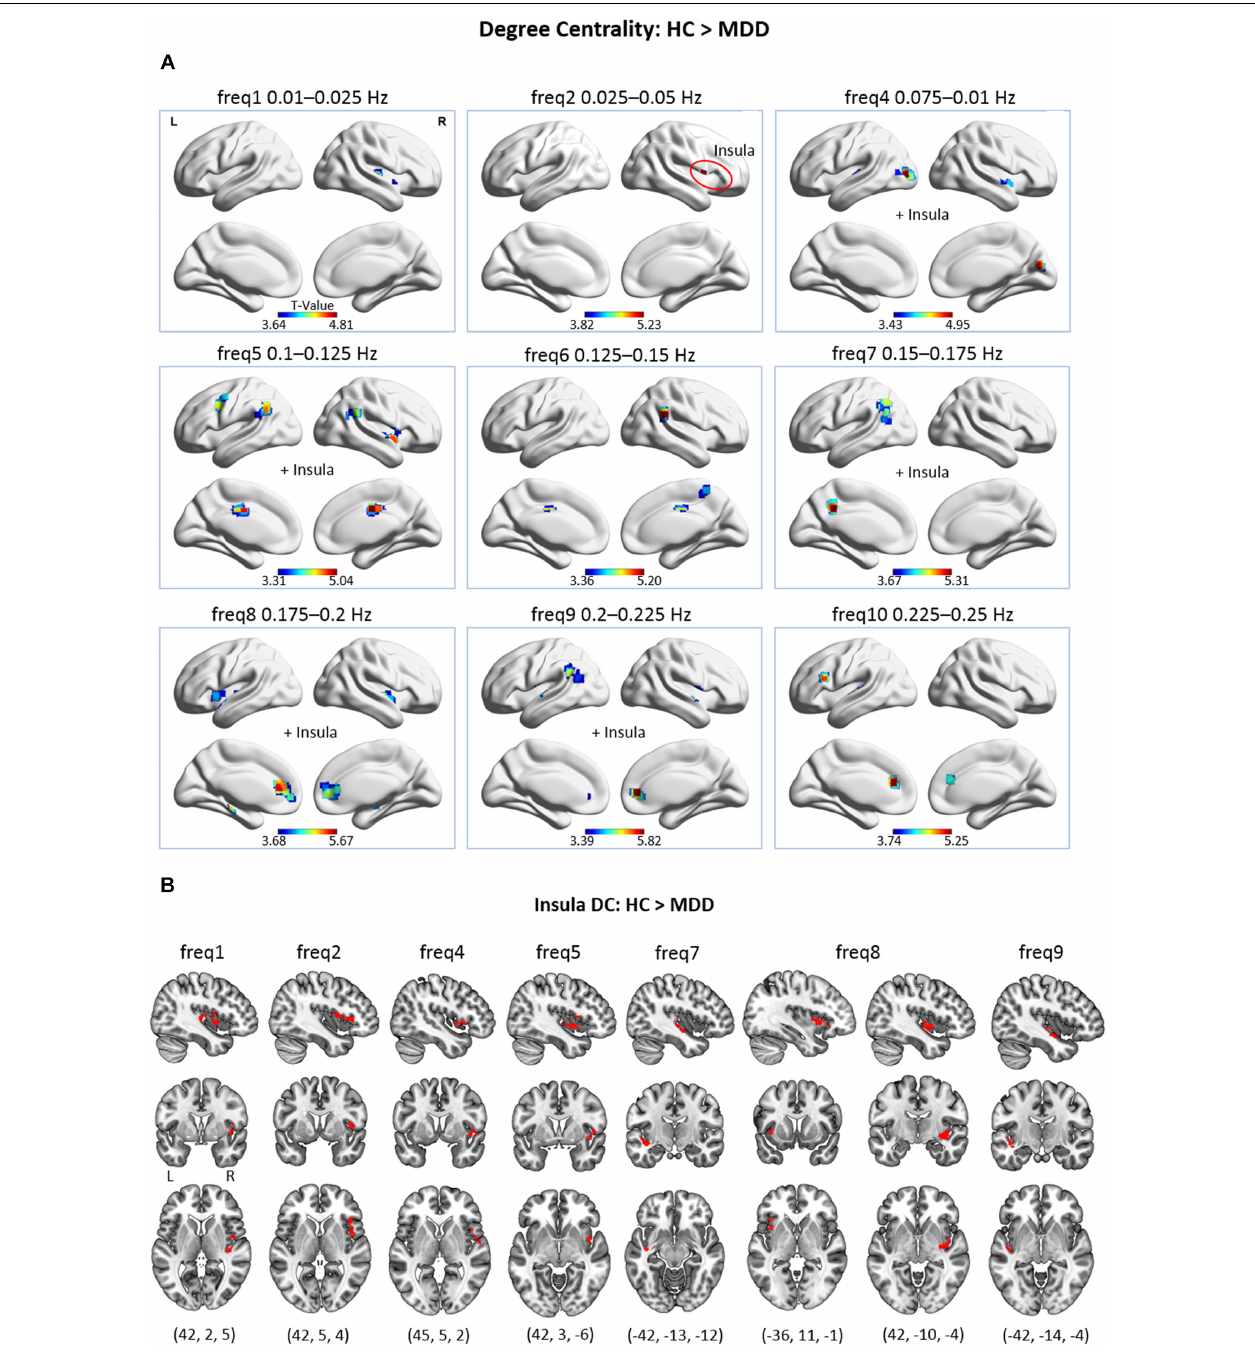
FIGURE 2 | (A) Group differences in voxel-wise DC across 9 frequency bands, as only the frequency bands where significant differences were found are displayed ( p cluster-level corrected < 0.05, on underlying voxel-level correction of p < 0.001, with voxels restricted to GM). At freq2, the cluster is located exclusively in the insular lobe. (B) Group differences in voxel-wise DC of the insular lobe at different frequency bands. This figure encloses Supplementary Information to panel (A) for improved visibility.